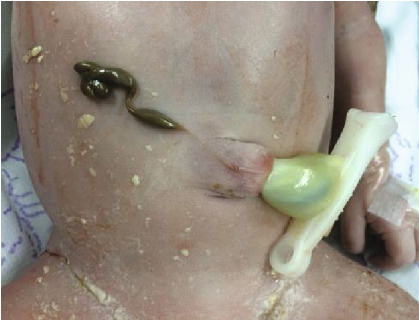
Figure 3: Paraumbilical remnant.